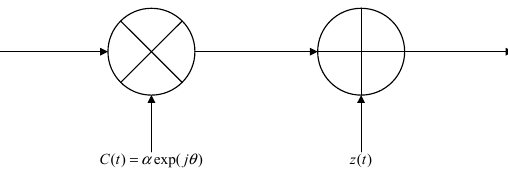
Figure 1. Ka-band satellite channel statistical model.